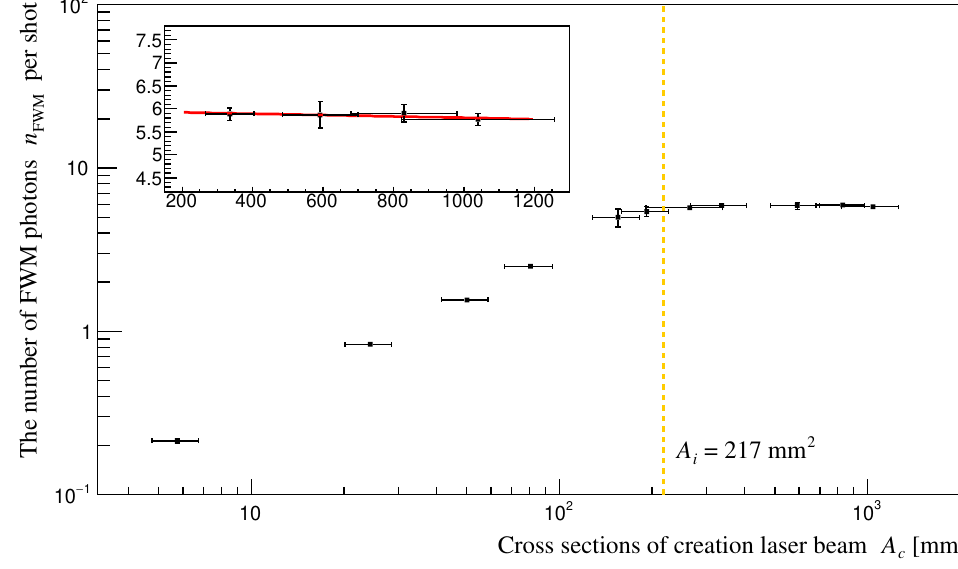
Figure 10 . Creation beam cross-section dependence of the number of observed FWM photons n FWM per shot, drawn on a double-logarithmic scale. The yellow dashed line is a fixed inducing pulse cross section A i = 217 mm 2 . Four datapoints from the right-most point, where creation pulse diameters are sufficiently larger than the inducing pulse diameter with considering errors, are shown enlarged in the insert with a linear scale. These were fitted with eq. (4.2), resulting in the slope e = ( − 1 . 5 ± 2 . 6) × 10 − 4 represented by the red line. Since the number of observed FWM photons are independent of the creation pulse cross section in the A c > A i region, the optical-element aFWM accounts for the observed